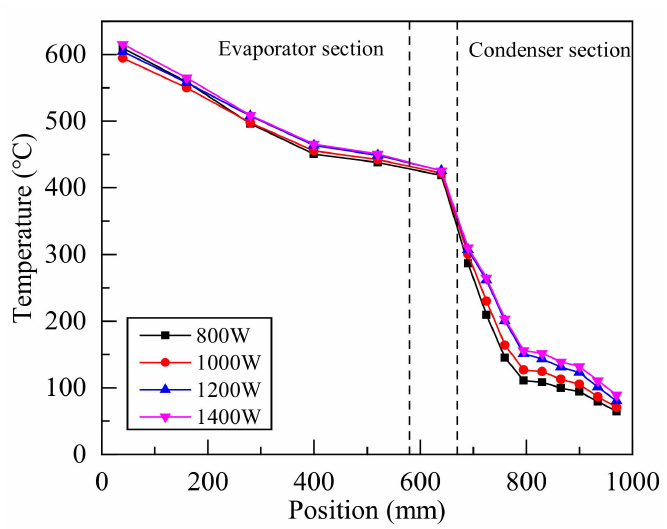
Figure 6. Average temperature distribution of heat pipe under different heating